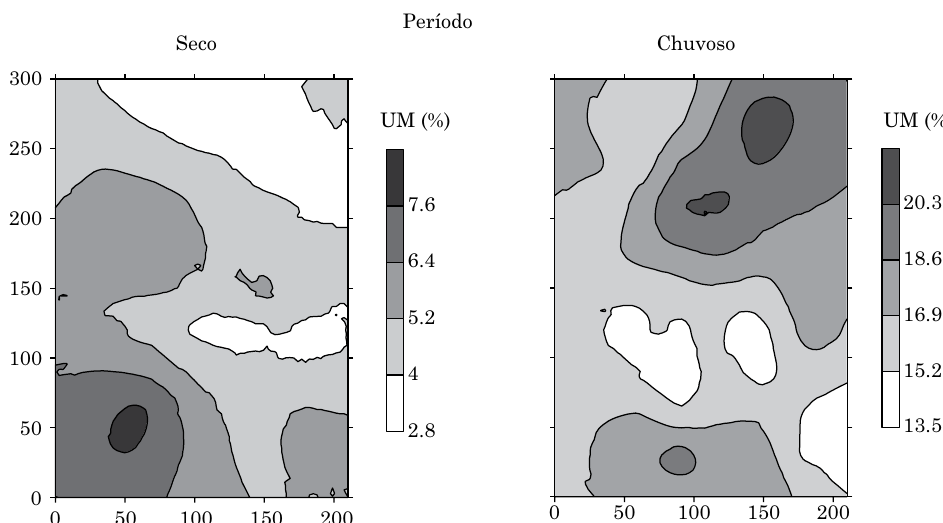
Figura 4. Mapas da umidade do solo (UM) nos períodos seco e chuvoso, em área de Neossolo Litólico